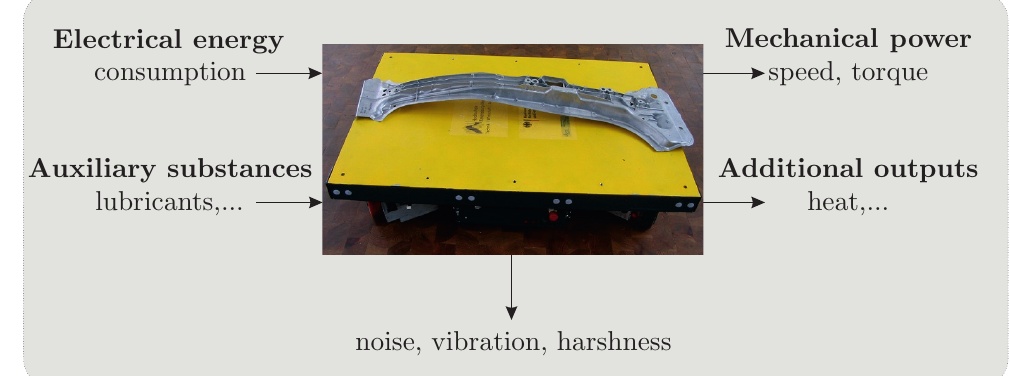
Figure 3. Black Box Diagram